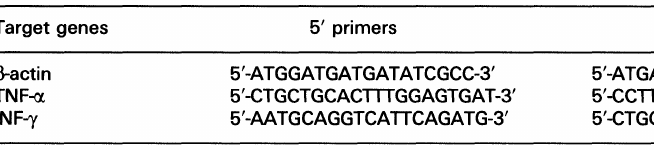
Table 1. Sequences of primers used in RT-PCR Target genes